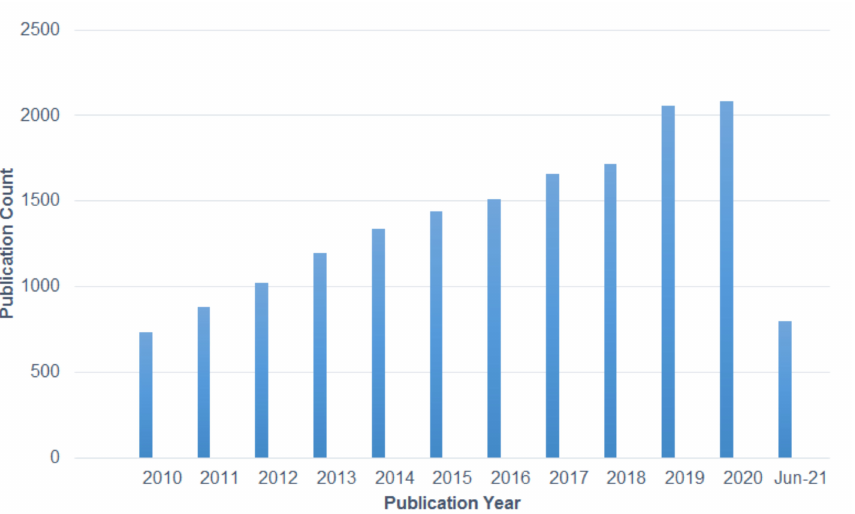
Figure 1. Graph showing the total relevant published articles on electrospun nanofiber-related re- search between 2010 and June 2021 by research outputs with the search topic “electrospun nanofibers” carried out using the Web of Science online search system as of 17 June